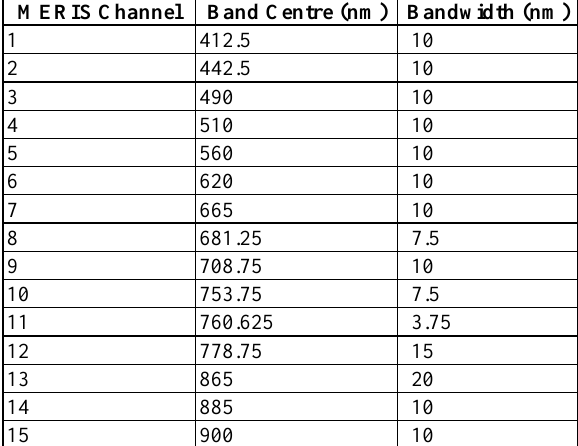
Table 7. MERIS spectral bands (MERIS, 2011).